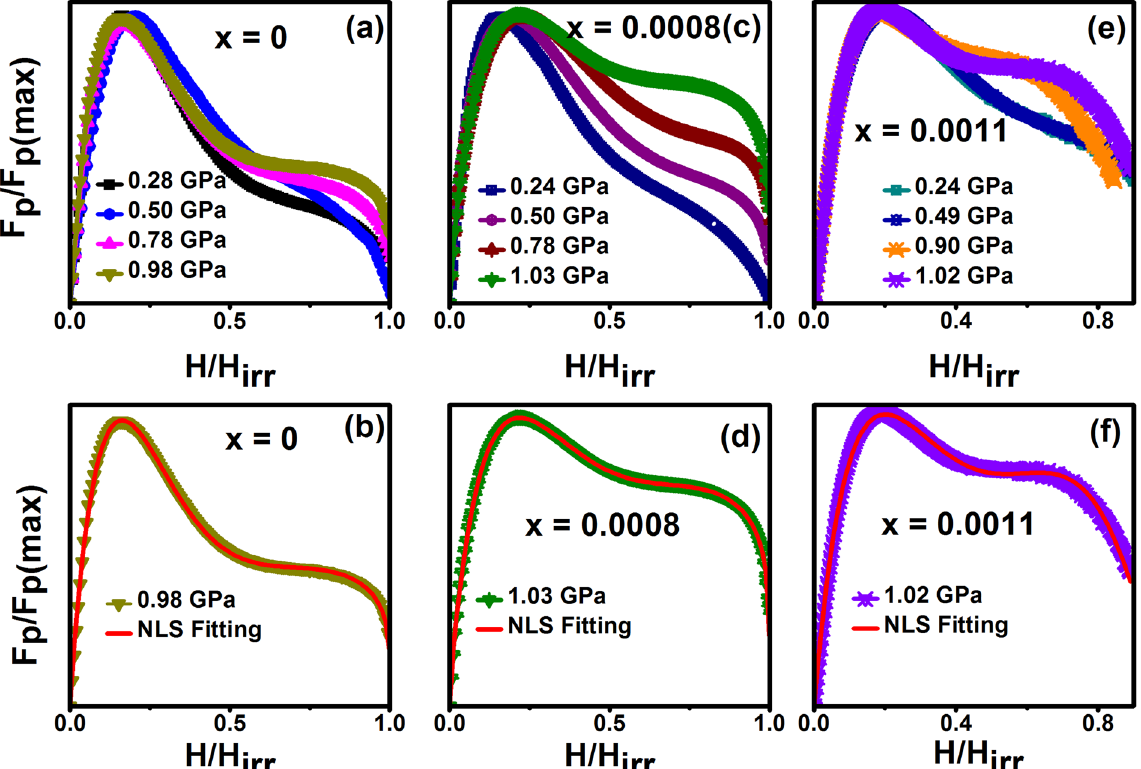
Figure 7. Normalized pinning force density (F p /F p(max) ) as a function of reduced magnetic field (H/H irr ) for various pressure for the samples Fe x NbSe 2 (x = 0, 0.0008 and 0.0011). Where ( a and b ) NbSe 2 , ( c and d ) Fe 0.0008 NbSe 2 and ( e and f ) Fe 0.0011 NbSe 2 . The solid lines are represents the nonlinear fitting using f p = Ah p (1-h) q + Bh r (1-h) s at different pressures for the samples Fe x NbSe 2 (x = 0, 0.0008 and